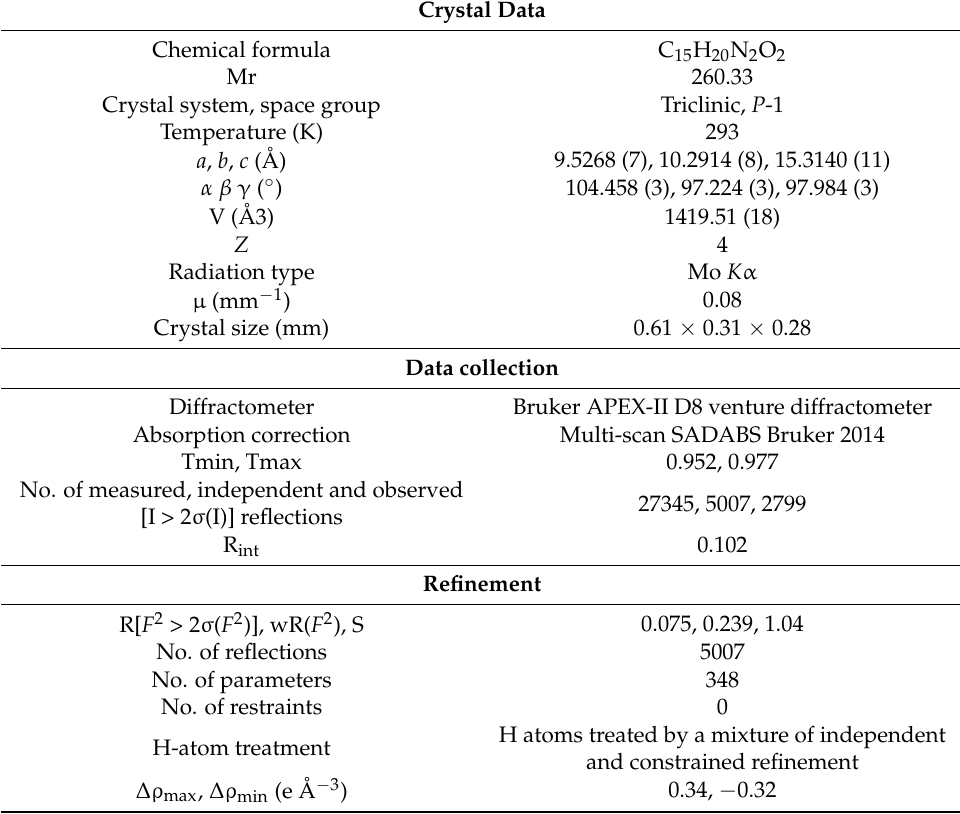
Table 1. Experimental details.